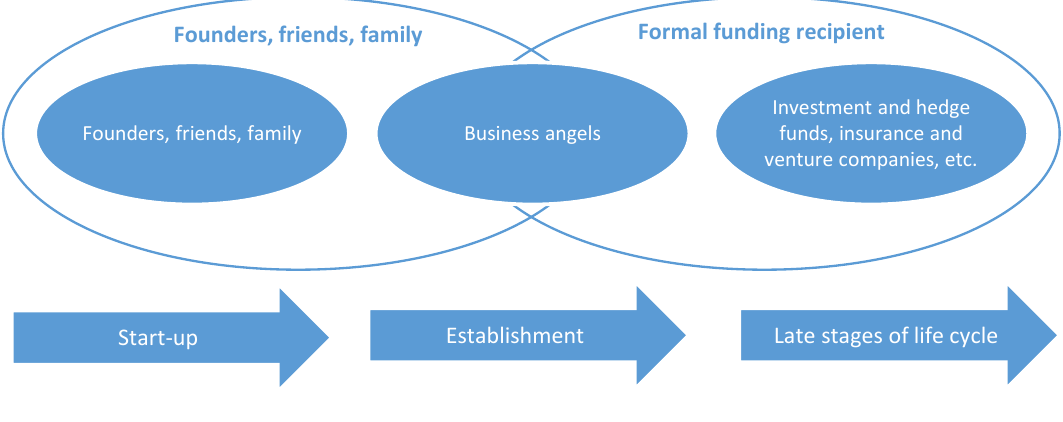
Figure 1. Capital investors at the start-up, establishment and late stages of a SBE life cycle